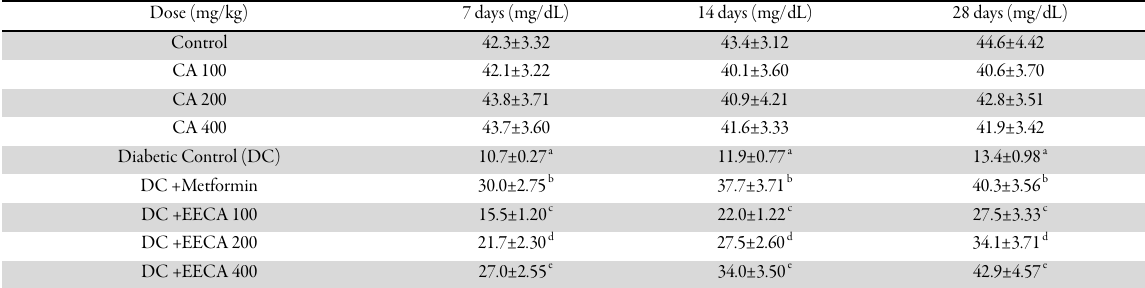
Table 7. Effect of Chrysophyllum albidum on high density lipoprotein cholesterol level of alloxan- induced diabetic rats